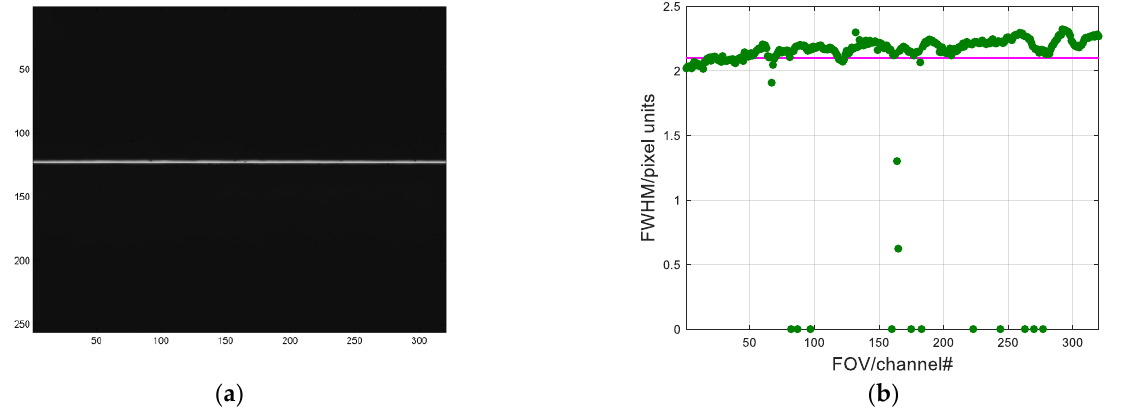
Figure 16. Imaging of the straight slit at 293 K. ( a ) a straight slit image; ( b ) the FWHM of the straight slit image. slit image.